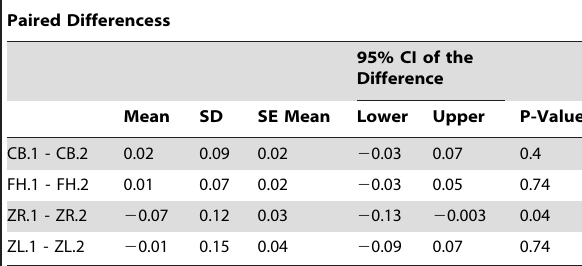
Table 4. Mean differences (mm) and 95% confidence interval (CI) between superimpositions registered on the left zygomatic arch and superimpositions registered on the anterior cranial